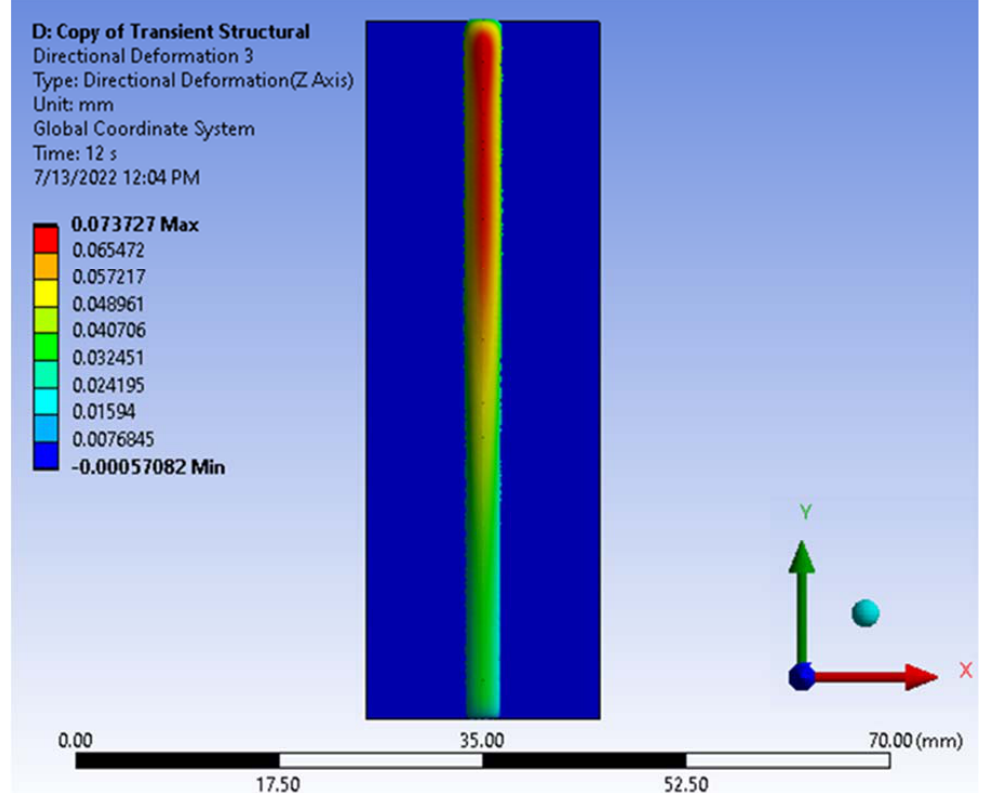
Figure 12. Two dimensional deformation profile of the specimen.